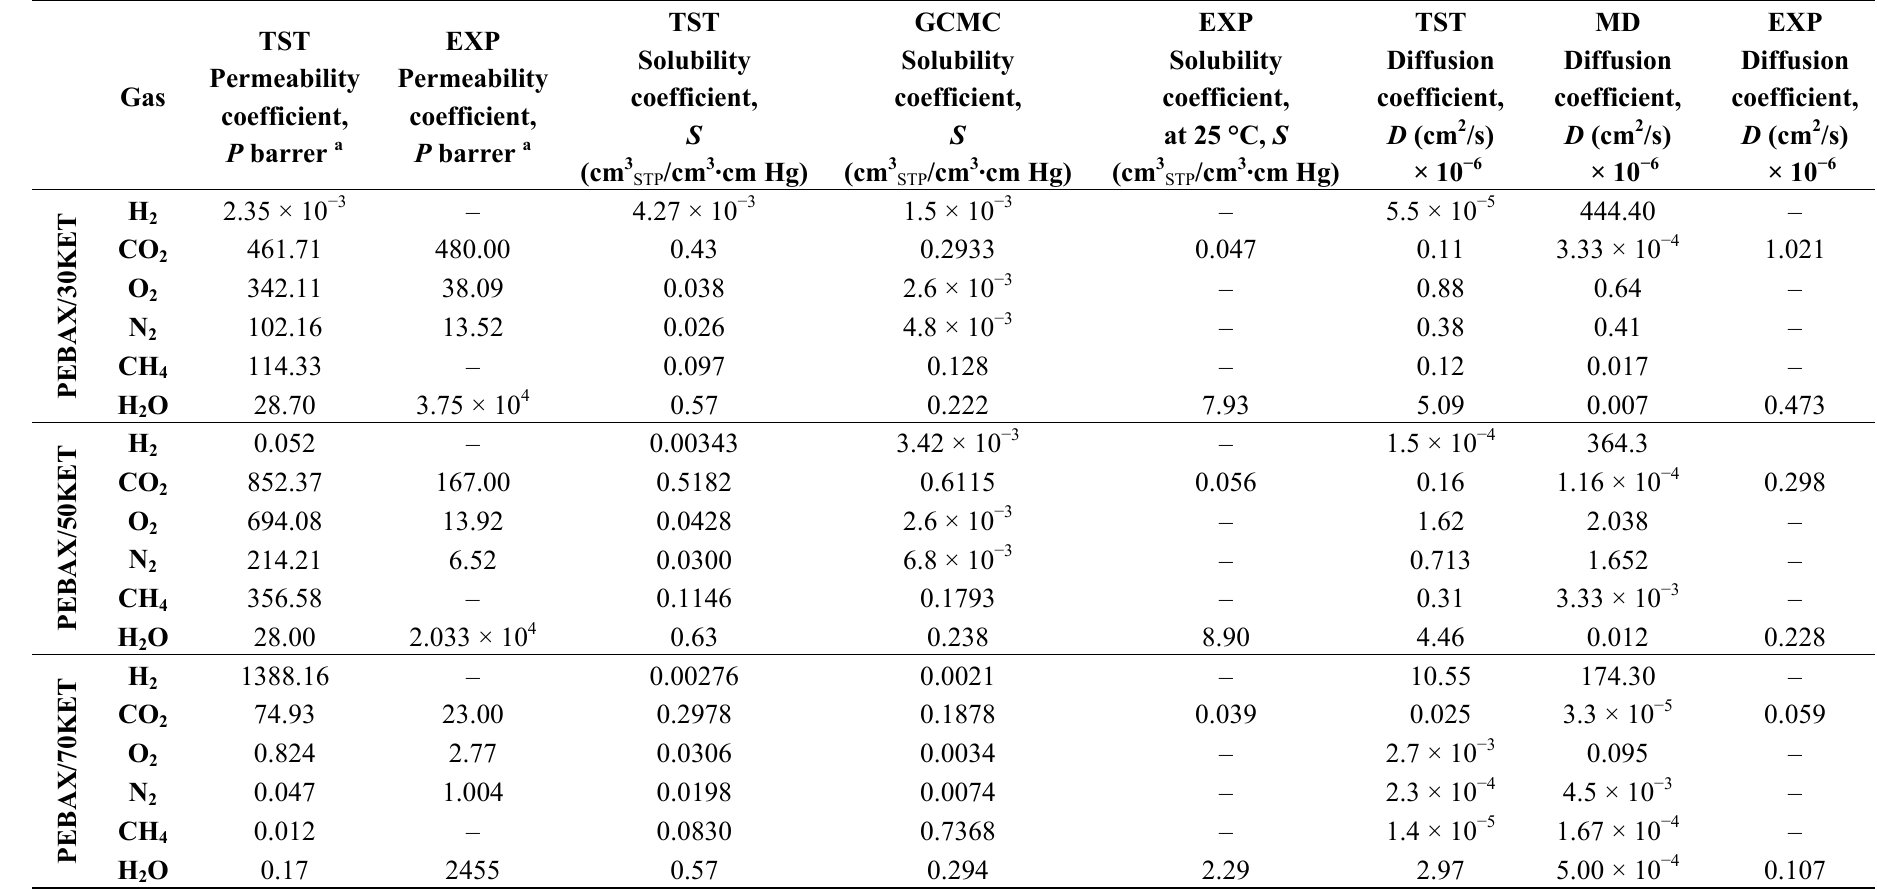
Table 3. Theoretical and experimental data: permeability, diffusion and solubility coefficients of PEBAX/KET